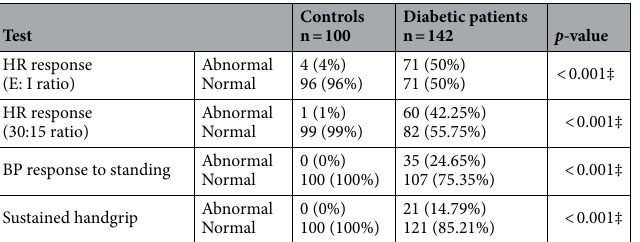
Table 2. Cardiovascular autonomic tests of the study population. DM = diabetes mellitus; HR = heart rate; E: I = expiration: inspiration; BP = blood pressure, ‡ chi-square.